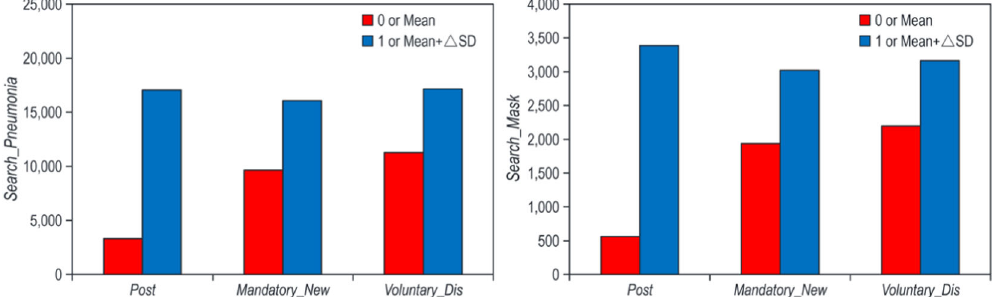
Fig. 5 Impact of government disclosure on behaviors of the susceptible — Internet searches for “ pneumonia ” and “ mask ” by the susceptible. Post is an indicator that equals 1 after a province entered the Category I public health emergency regime and 0 before. Mandatory_New is the daily new con fi rmed cases for a province. Voluntary_Dis is the number of independent disclosures by a province ’ s Center for Disease Control (CDC). For indicator Post, the red column represents Internet searches for “ pneumonia ” ( “ mask ” ) when Post is 0 and the blue column represents Internet searches for “ pneumonia ” ( “ mask ” ) when Post is 1. For continuous variables Mandatory_New and Voluntary_Dis, the red column represents Internet searches for “ pneumonia ” ( “ mask ” ) when they are at their mean and the blue column represents Internet searches for “ pneumonia ” ( “ mask ” ) when they are at their mean plus one standard